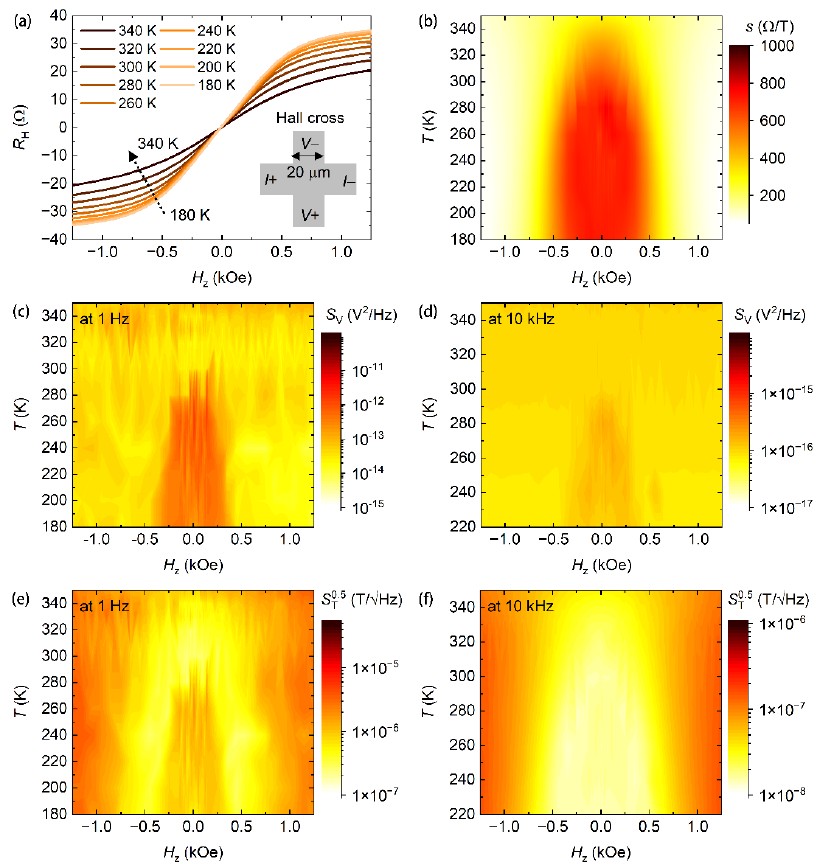
Figure 3. ( a ) Hall curves measured at different temperatures (180 to 340 K with a temperature interval of 20 K) for a multilayer stack of MgO(1.6)/Fe 0.48 Pt 0.52 (1.25)/MgO(1.6)/TaO x (1.0). The insert shows the schematic of the Hall cross. Maps of ( b ) the sensitivity s , ( c ) Hall voltage noise 𝑆 V at 1 Hz, ( d ) Hall voltage noise 𝑆 V at 10 kHz, ( e ) field detectability 𝑆 T0.5 at 1 Hz and ( f ) field detectability 𝑆 T0.5 at 10 kHz, as a function of temperature T and the perpendicular magnetic field 𝐻 z . In ( d ) and ( f ), only results in the temperature range from 220 to 350 K are given.